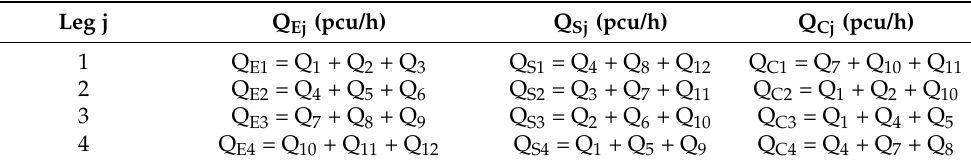
Table 2. Calculation of entering, exiting, and circulating traffic